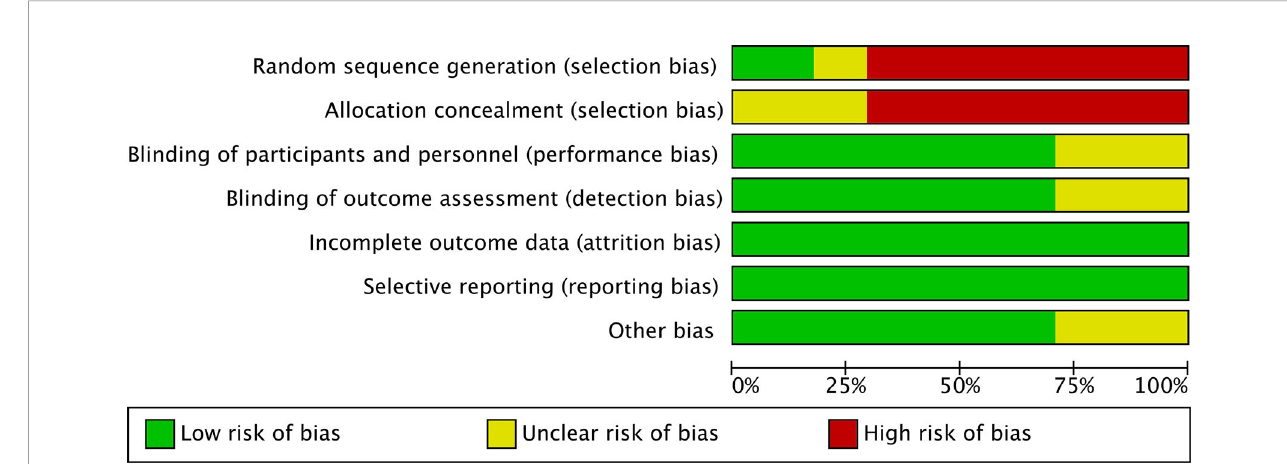
FIGURE 2 | Results of literature quality risk of bias summary.